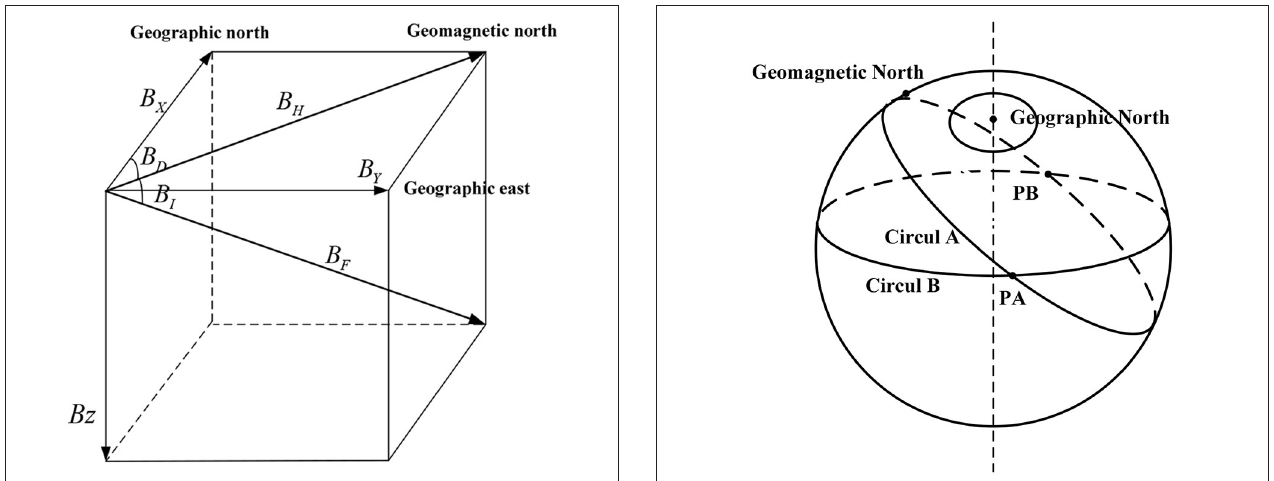
FIGURE 2 | The uniqueness of geomagnetic